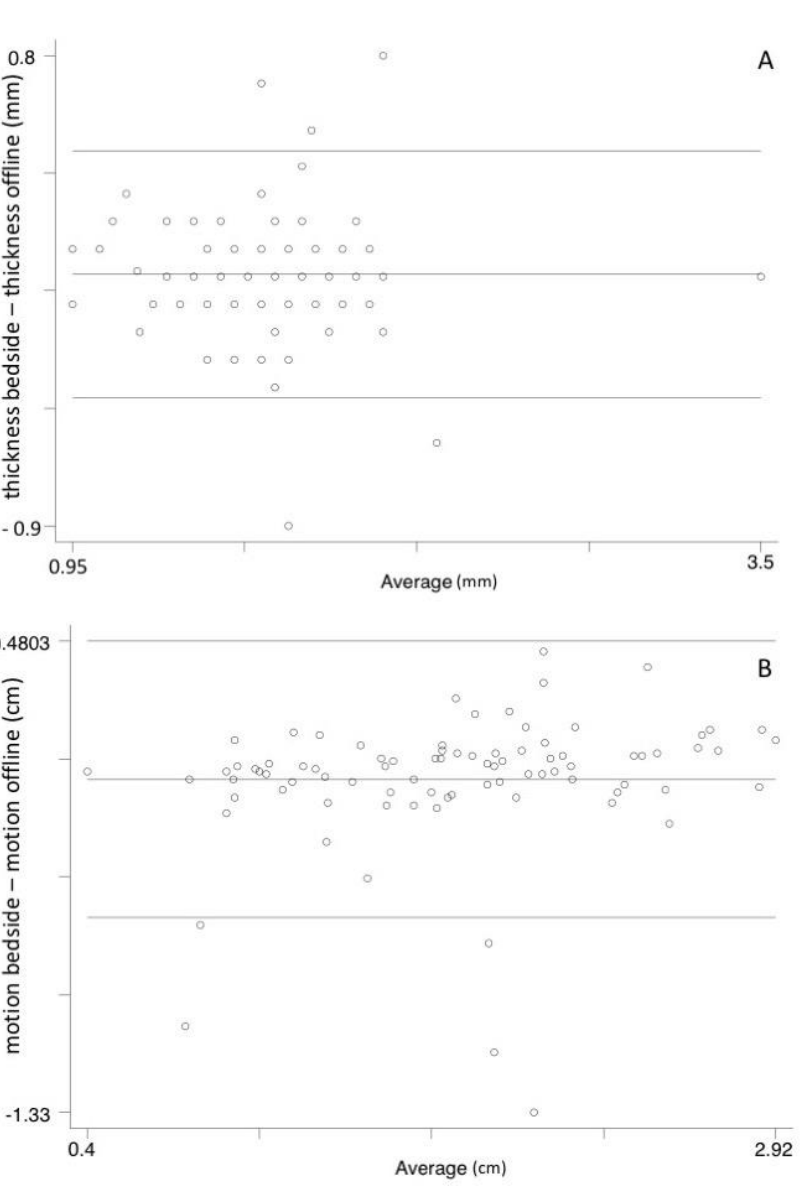
Figure 2. Bland–Altman plots for agreement between diaphragm thickness and motion measurement bedside and offline (Panel ( A ) and ( B ), respectively).